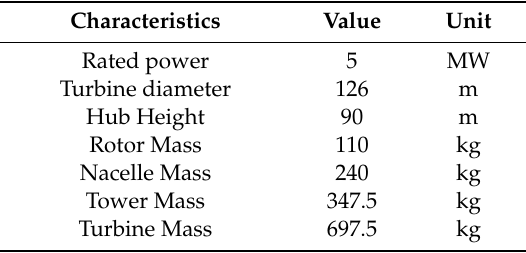
Table 1. Turbine characteristic